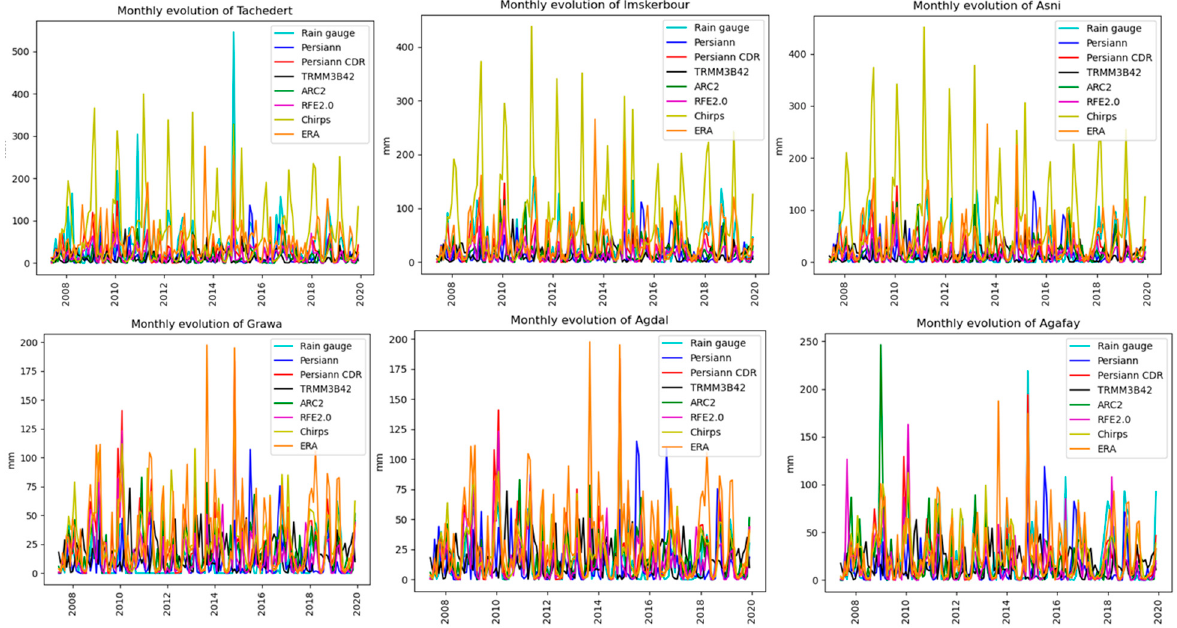
Figure 6. Temporal evolution of monthly rainfall rates (mm) for each weather station and corresponding satellite pixels.